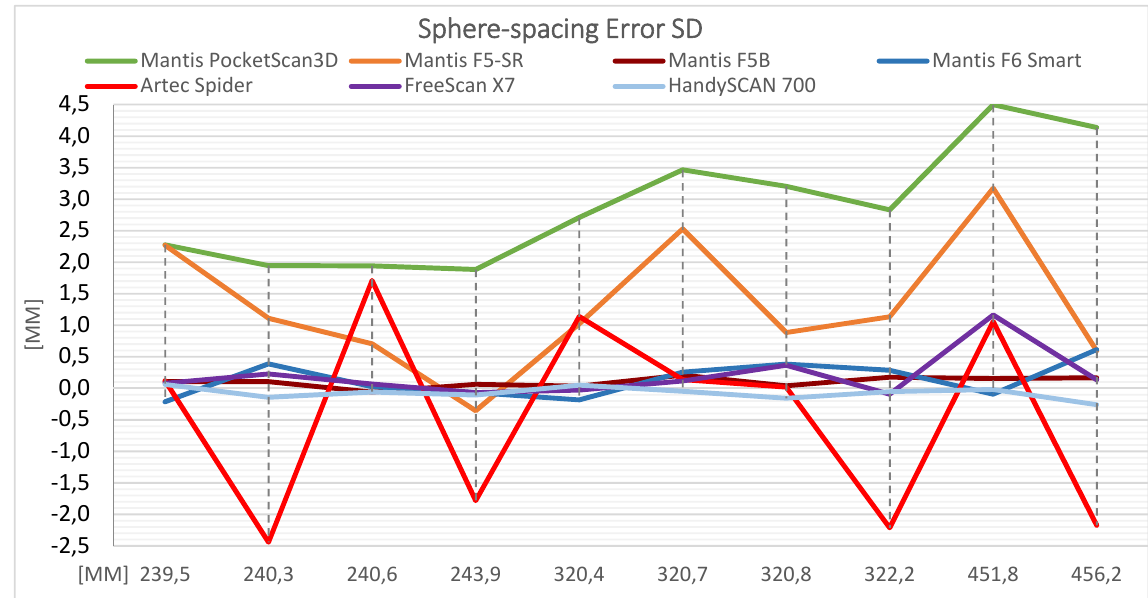
Figure 5. Quality parameter sphere-spacing error (SD) equivalent to VDI/VDE 2634, part